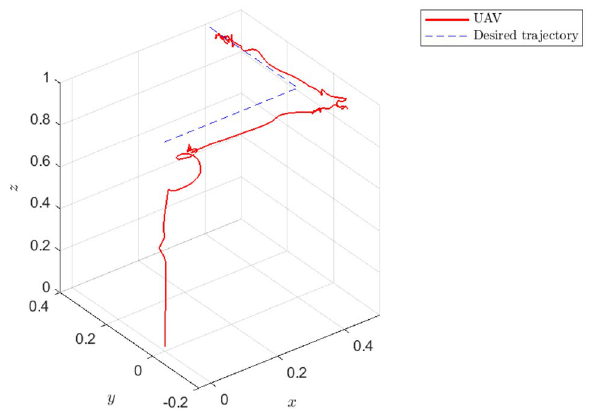
Figure 15. The profile of x , y and z in the experimental test using NAS in